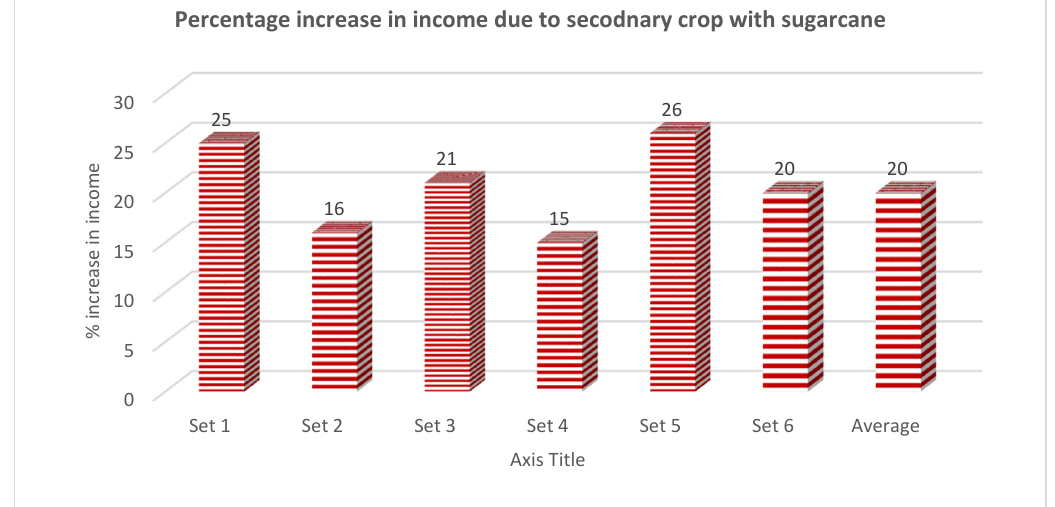
Figure 10. The percentage increase in income due to secondary crop with sugarcane. The secondary crop, on average, contributes to around 17% (with the range between 13% and about 20%) of the total income of trench method sugarcane cultivation with multi ‐ cropping. (Figure 11).